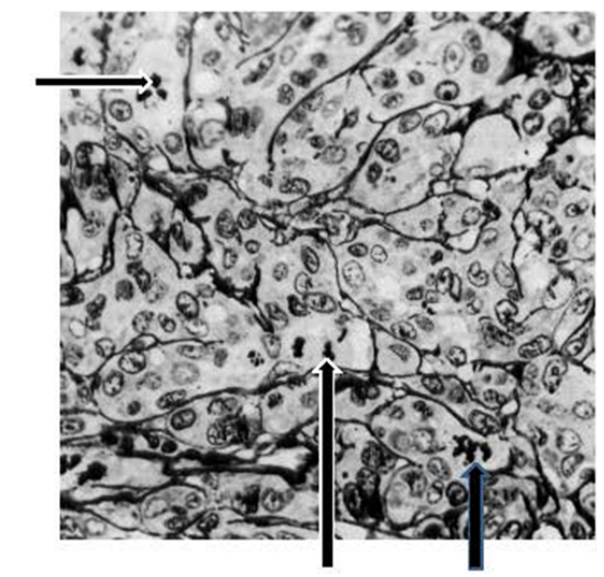
Figure 1. Tupaia belangeri : sebaceous jugulo-sternal gland carci- noma; Movat, 100 × . Arrows: atypical mitotic figures.